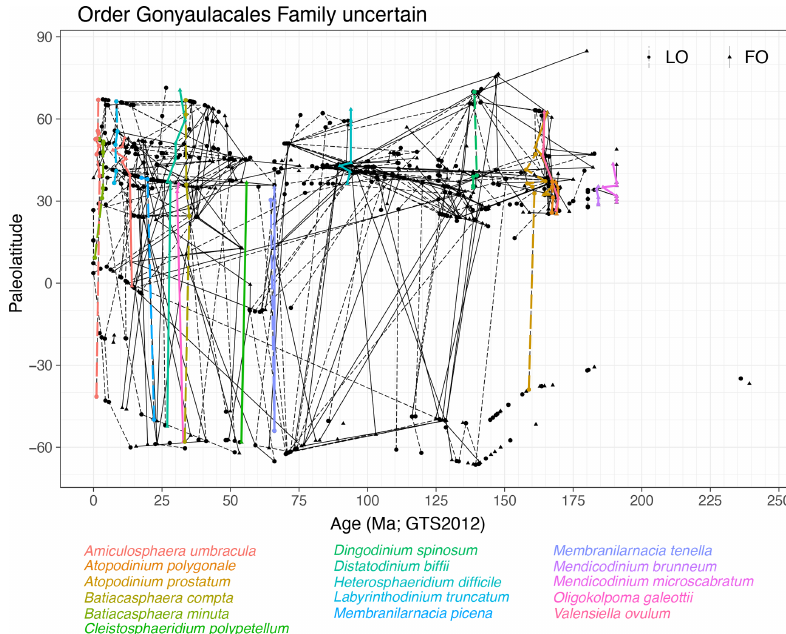
Figure 17. Same as Fig. 5 but for the order Gonyaulacales, family uncertain.